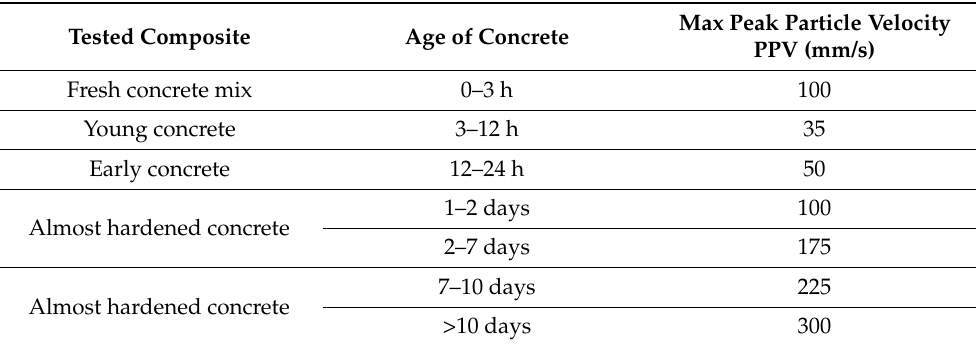
Table 3. Limitations of maximum vibration velocity in the course of